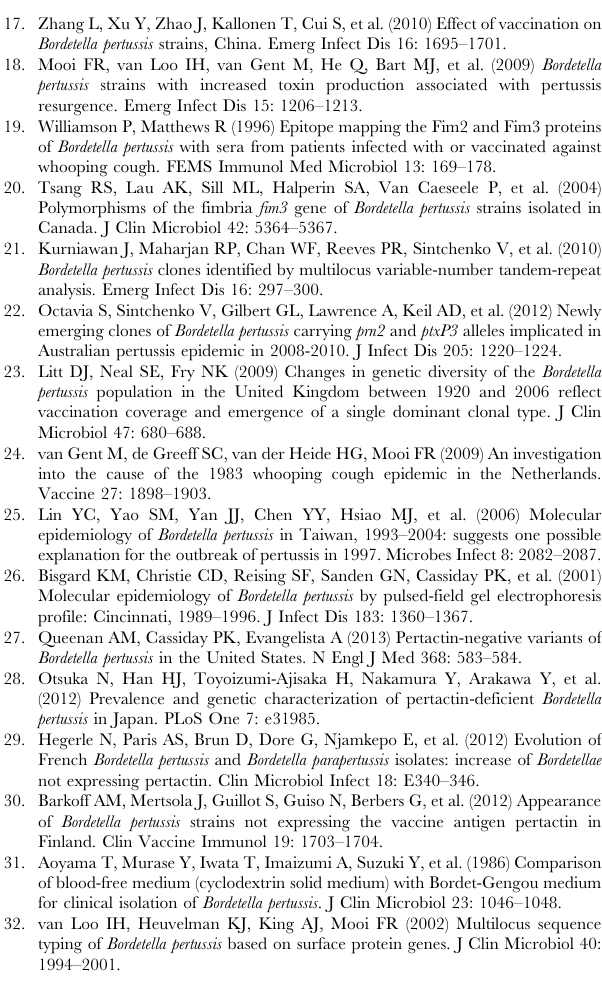
Table S1 Characteristics of Bordetella pertussis study isolates. Table S2 PCR primers in this